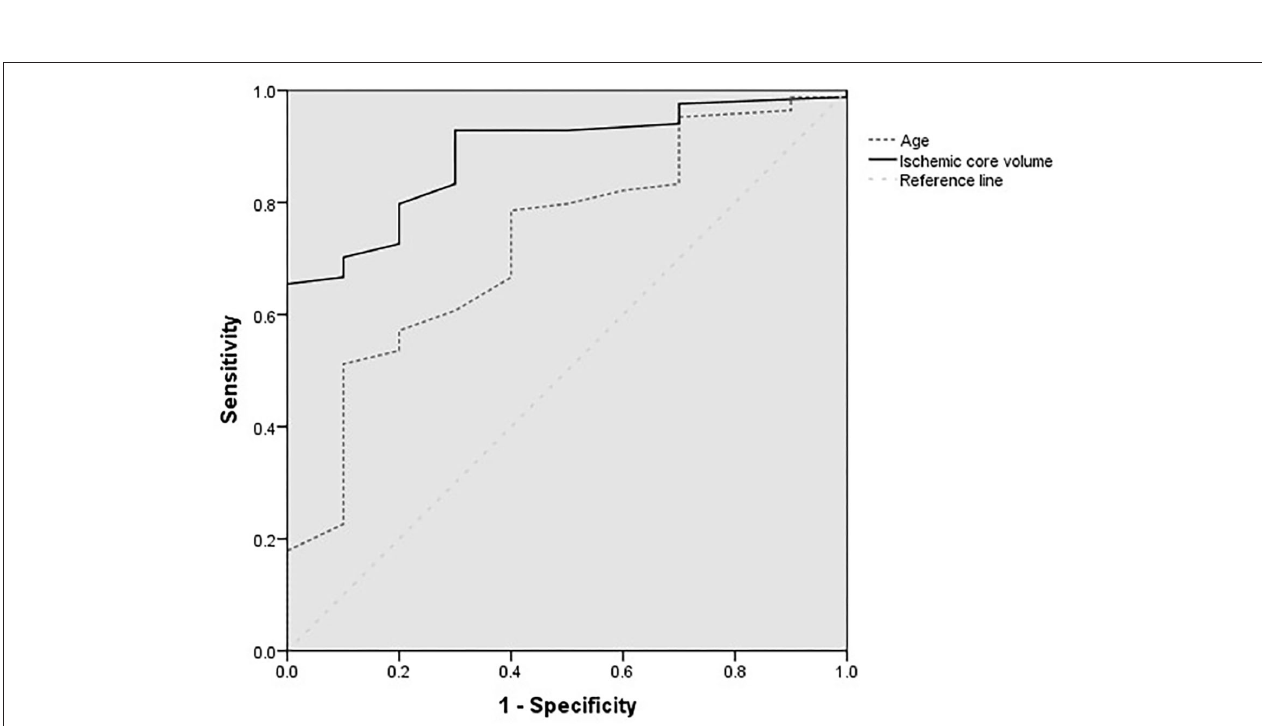
Frontiers in Neurology |